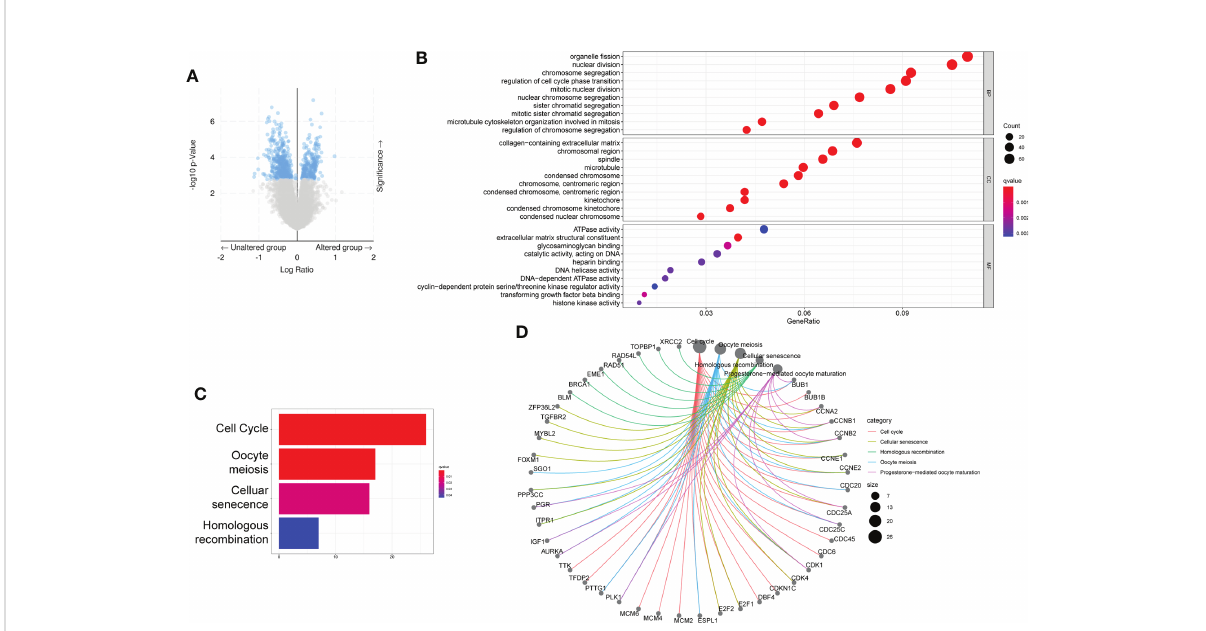
FIGURE 5 Differential expressed gene based on the mutation status of the six genes. (A) Volcano fi gure of differently expressed genes from cBioPortal database. (B – D) GO (B) and KEGG (C, D) analysis based on the differently expressed genes.